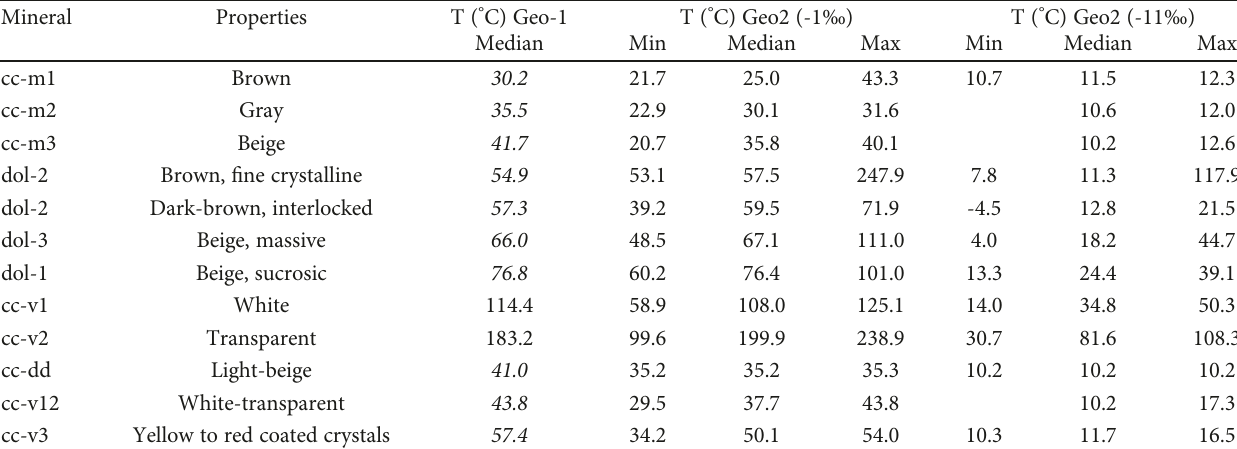
Table 6: Paleotemperature from isotopic geothermometers ( δ 18 O values Table 2); Geo-1: 18 O geothermometers according to Liedmann [18]; Geo-2: 18 O geothermometer after Friedman and O'Neil [64] for calcite and Fritz and Smith [67] for dolomite and for paleo fl uids with an 18 O value of -1 ‰ SMOW and -11 ‰ SMOW; bold — reliable data.